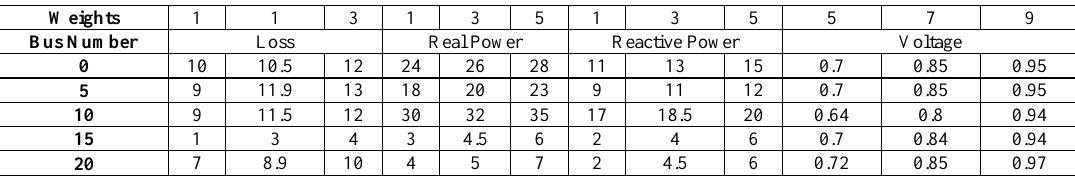
Table 9. Decision matrix (uncertain